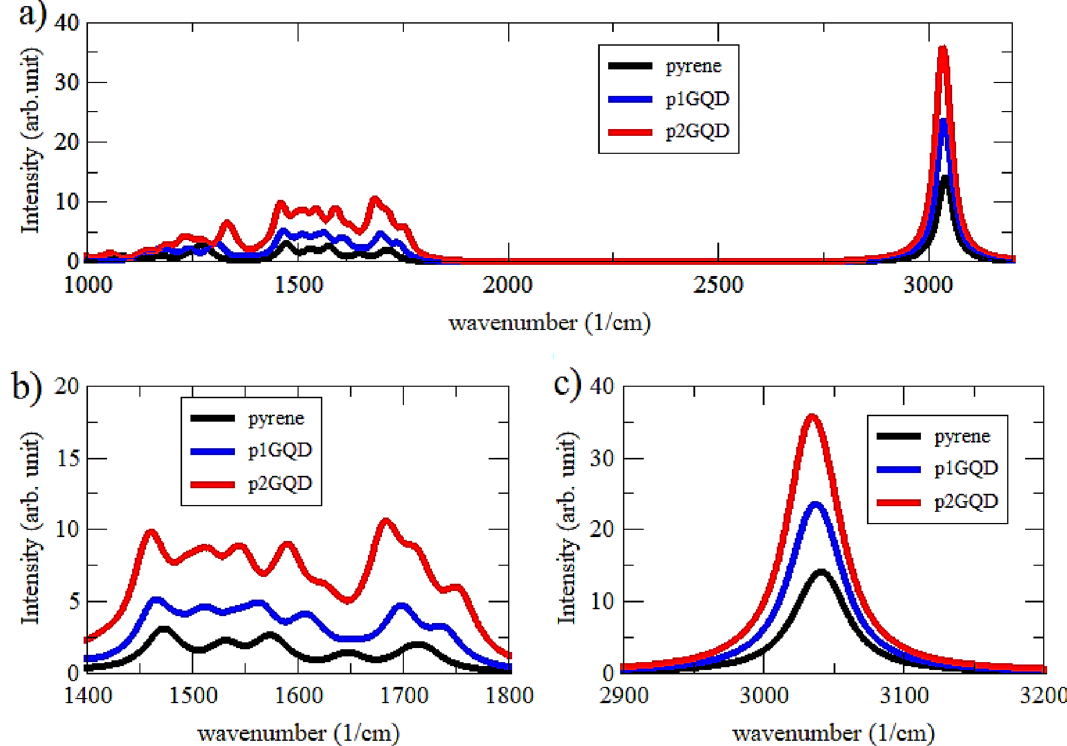
Figure 3. Simulation result of the vibrational mode ( a ), C=C stretch ( b ), and C–H stretch ( c ) of Pyrene, p1GQD, and